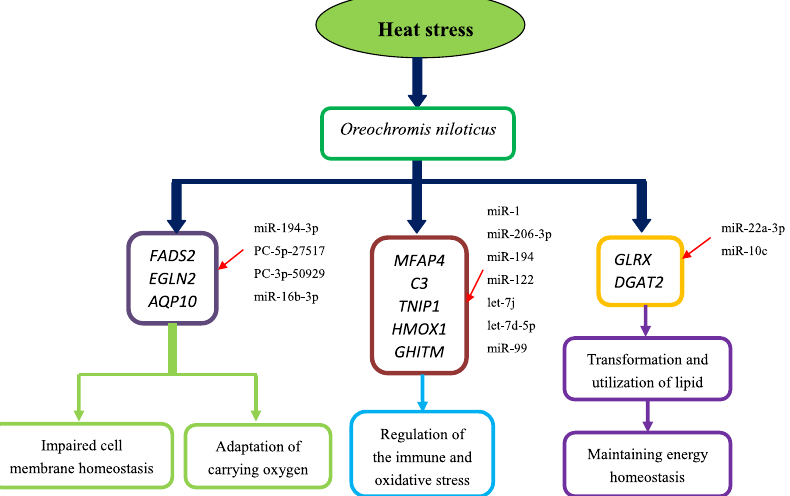
Figure 9. Diagram of regulated pathways in liver of GIFT exposed to 37.5 °C heat-stress for 24 h. The pathways involved mainly impaired cell membrane homeostasis, intervention in the immune response, stimulated lipid synthesis, decomposition, and utilization, and regulation of antioxidants and cell